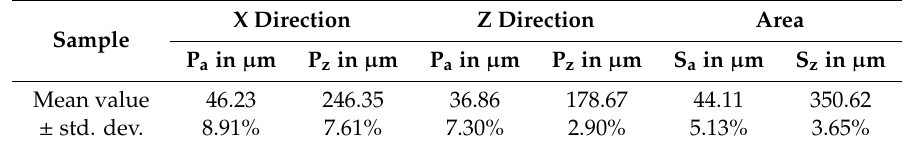
Table 11. Primary profile and areal parameters of the sample surfaces measured with laser scanning microscopy.